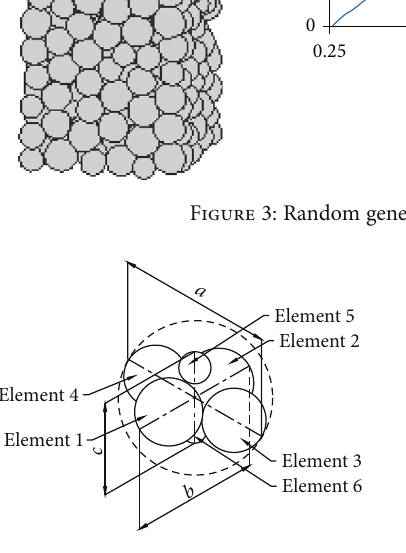
Figure 4: Particle shape of the 6-element